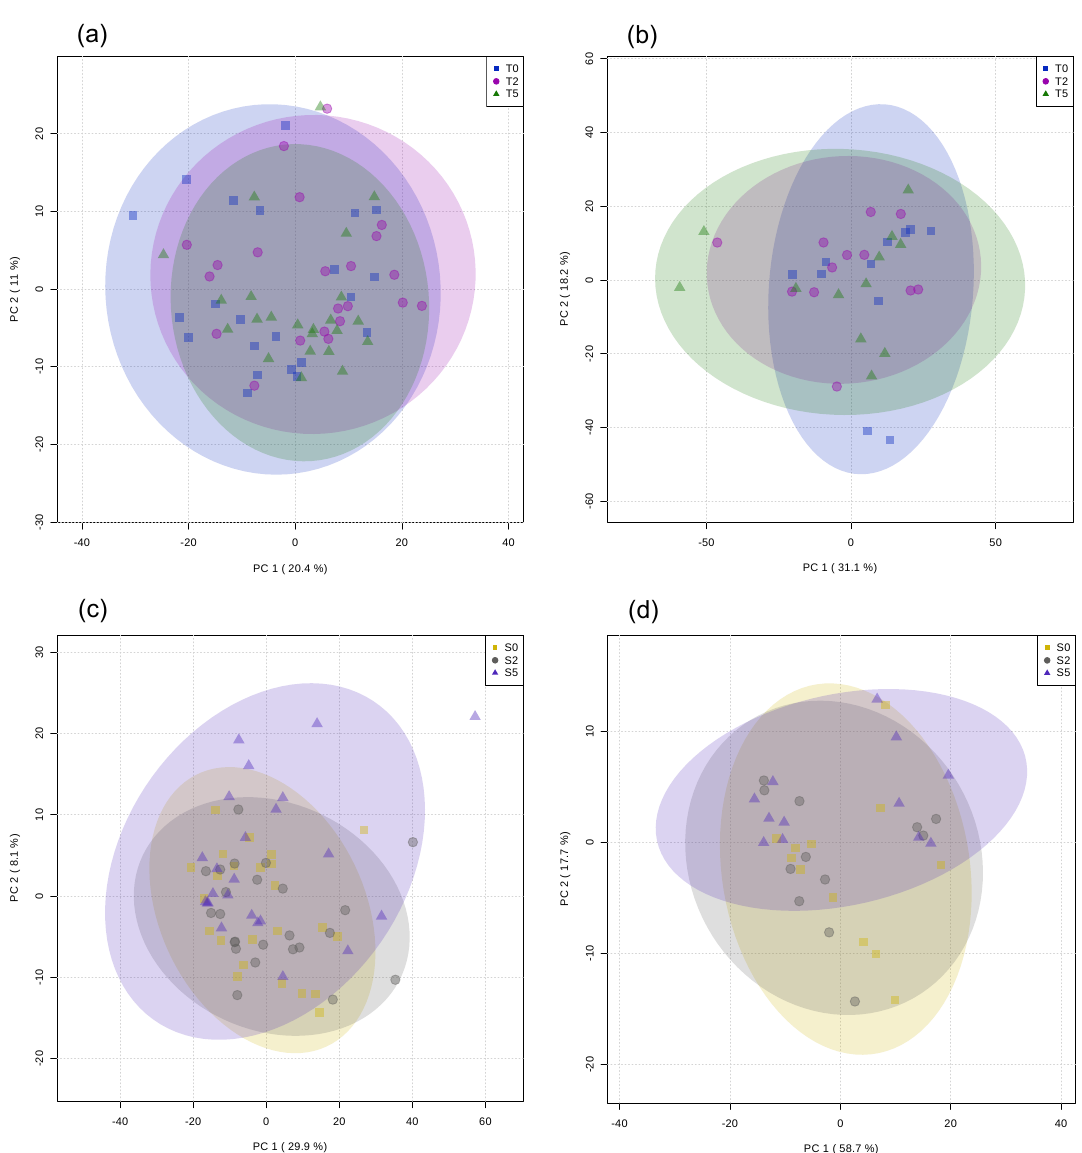
Figure 2. Principal component analysis (PCA) scores plot computed using multivariate analysis of: ( a ) 1D 1 H NMR spectra of the muscle aqueous fraction, ( b ) CPMG spectra of the liver aqueous fraction of rainbow trout fed a control diet (T0: 0% glycerol) and two experimental diets (T2: 2.5% and T5: 5.0% glycerol), ( c ) 1D 1 H NMR spectra of the muscle aqueous fraction, and ( d ) CPMG spectra of the liver aqueous fraction of European seabass when subjected to di ff erent experimental diets (S0: Control, S2: 2.5% glycerol, S5: 5.0%